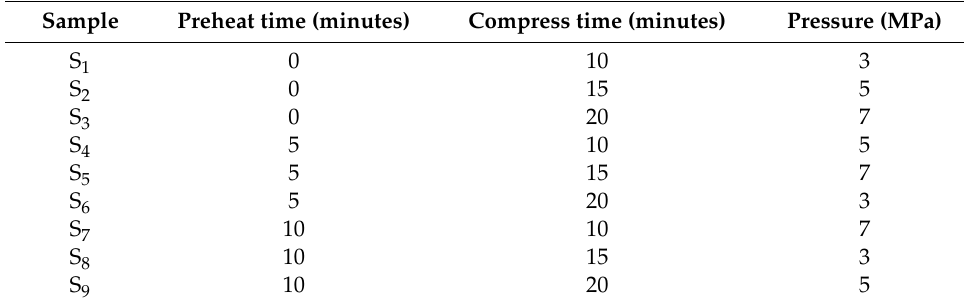
Table 1. Parameters applied for polypropylene / milled carbon fibre / exfoliated graphene nano-platelets / synthetic graphite (PP / MCF / xGNP / SG)